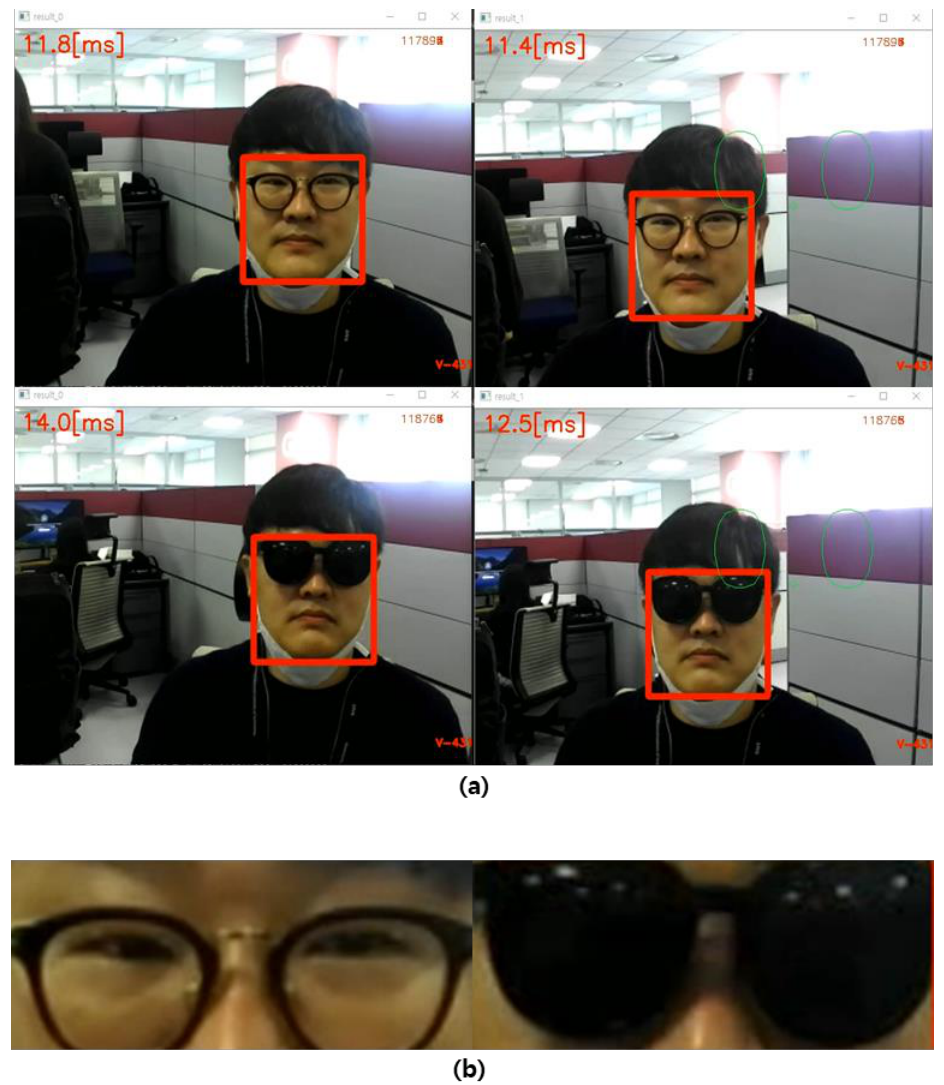
Figure 3. ( a ) Entire-face detector, which detects both bare faces (1st row) and sunglasses-wearing faces (2nd row). Each column shows the left and right image from the stereo camera. ( b ) Cropped eye regions for the classification of bare and sunglasses-wearing faces. Cropping was performed using the statistical mean shape determined according to training dataset labeling.